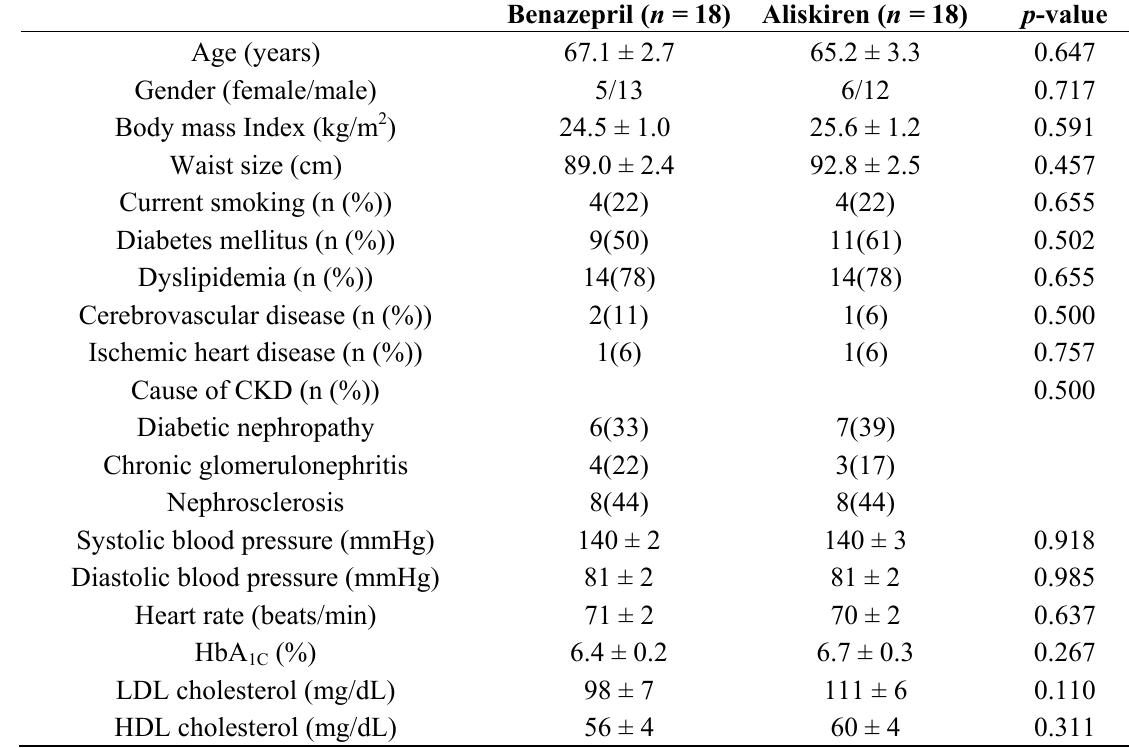
Table 1. Demographic characteristics of the study groups at